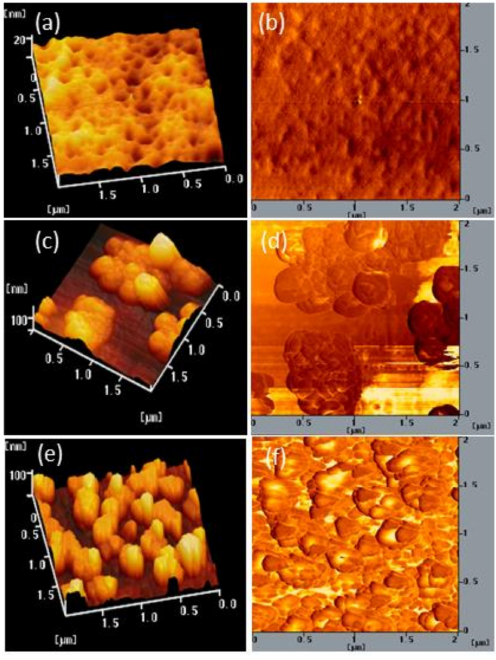
Figure 9. ( a , c , e ) Topographic and ( b , d , f ) phase AFM images of a BCP/PVP (5:1, w/w ) film after storage at 30 ◦ C and 35% relative humidity for ( a , b ) 0, ( c , d ) 5, and ( e , f ) 10